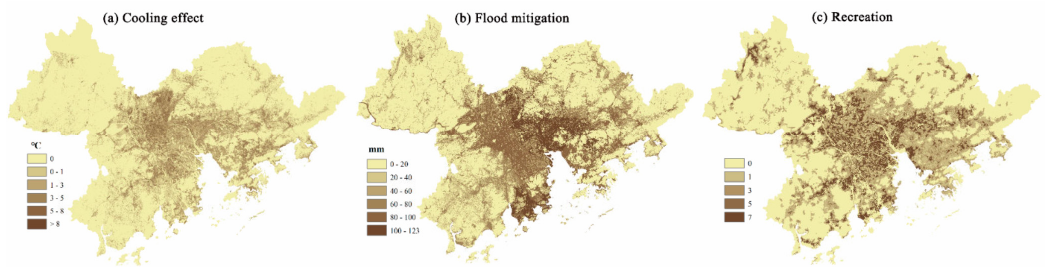
Figure 3. Mismatches between the supply and demand for the target ecosystem services (ES) in the GBA.